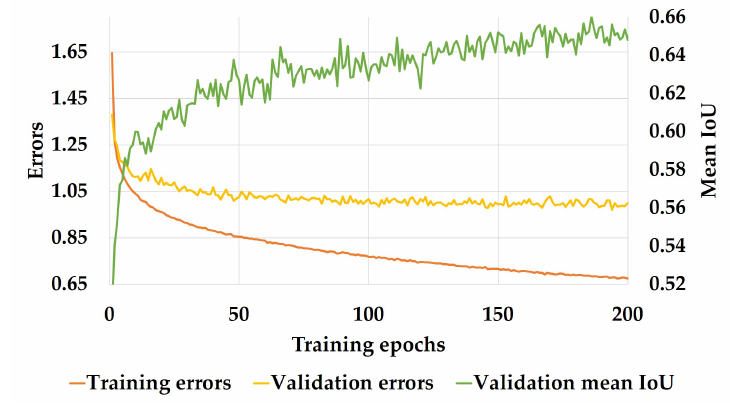
Figure 7. Training progress, IoU: